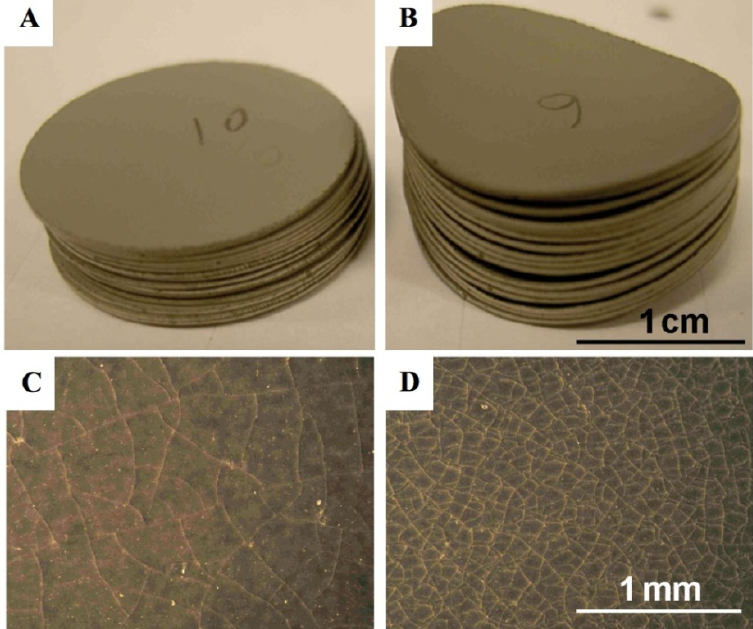
Figure 8. Picture of Ni-YSZ anode supported half-cell discs after 5 reduction-oxidation cycling (RedOx cycles) at 750 °C. ( A ) and ( C ): samples with 17.5% as-sintered porosity and ( B ) and ( D ): samples with 12% as-sintered porosity. The electrolyte is face-down for ( A ) and ( B ). A clear difference in curvature is observed between the two groups of samples comparing ( A ) and ( B ), ( B ) is bent towards the anode (anode face-up on the concave side). A clear difference in crack density is observed between the two groups of samples comparing ( C ) and ( D ) [98]